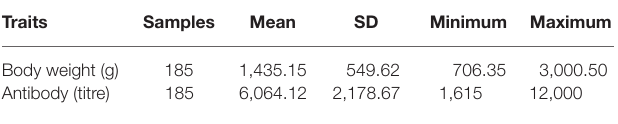
TABLE 1 | Means and SDs for 20-week body weight (BW) and antibody titres to Newcastle disease (ND) traits.